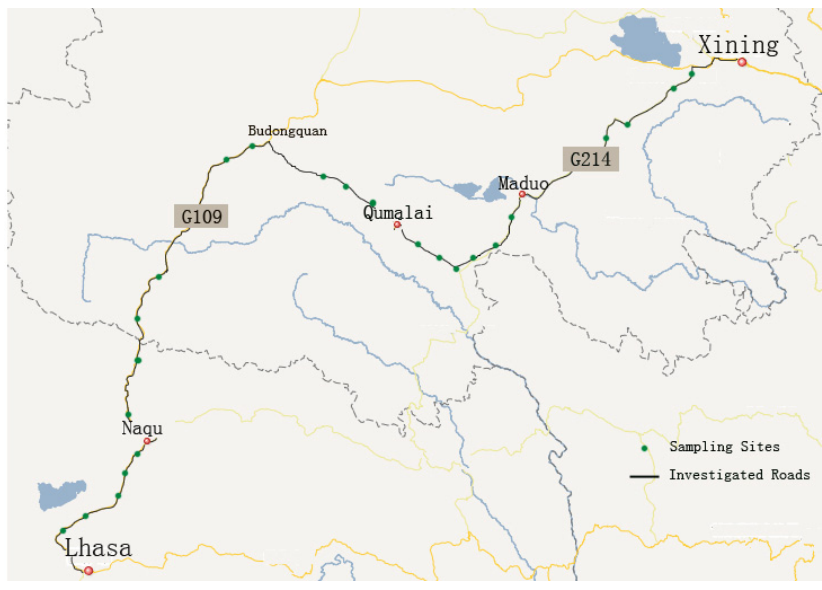
Figure 1. The sampling site distribution in the study